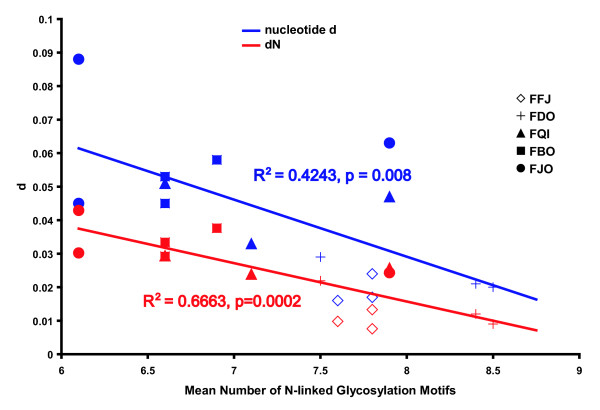
Glycosylation of SIVsmm V1V2 is inversely correlated with pairwise nucleotide diversity.